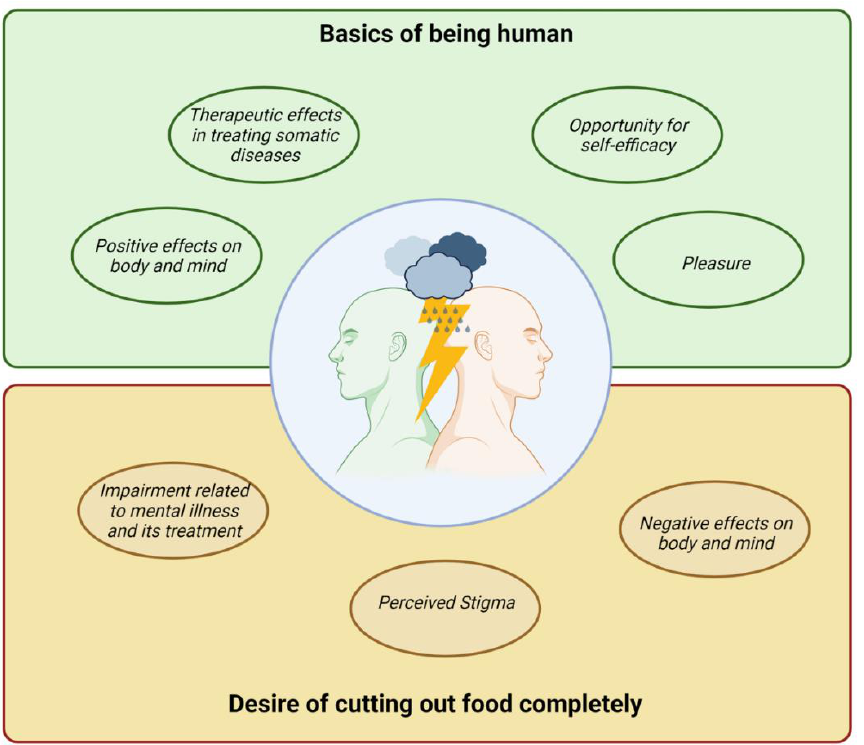
Figure 1. Thematic presentation of subjective implications of diet for people with mental illness. This figure was created with BioRender.com (accessed on 30 May 2022).